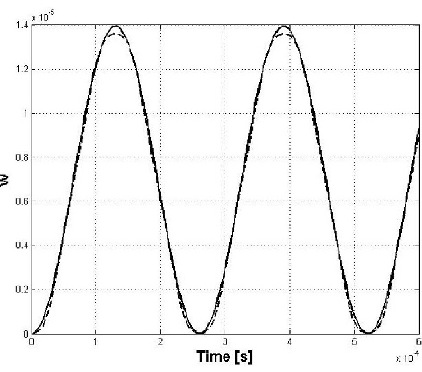
Figure 7. Response of a simply supported plate subjected to a step pressure load (___ one mode; - - - four modes analysis)